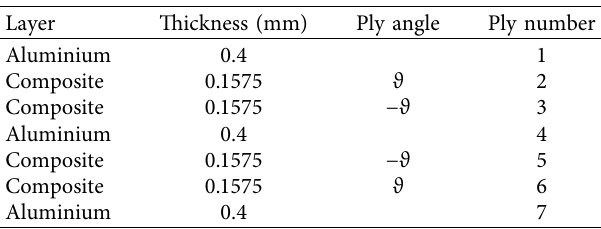
Figure 3: Finite element model of laminate. Table 4: Layout and structure of the laminate [47].